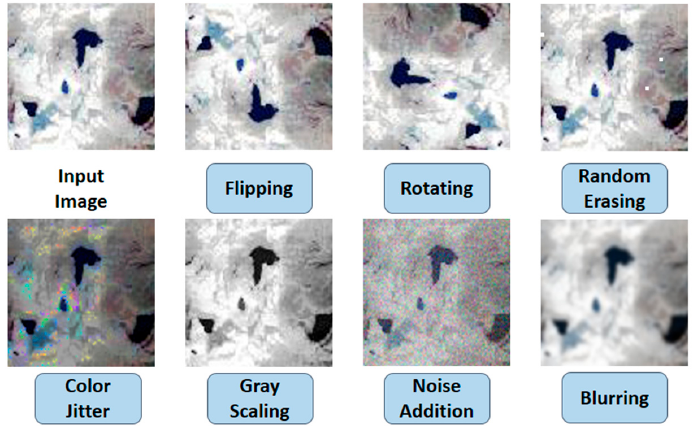
Figure 3. Different ways to generate the augmentations of multi-band RS images.